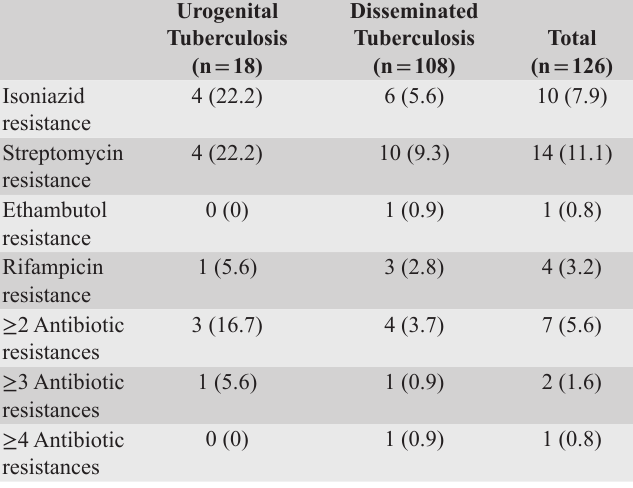
Table 2. Antibiotic Resistance Among Patients with Positive Mycobacterial